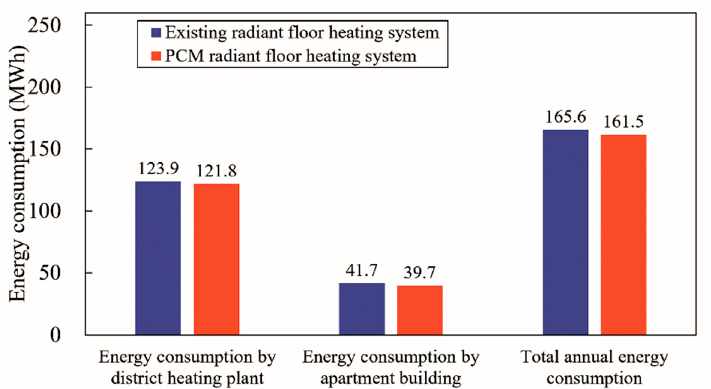
Figure 11. Annual energy consumptions of the PCM radiant floor heating systems. 276 Energies 2019 , 12 , x 14 of 17